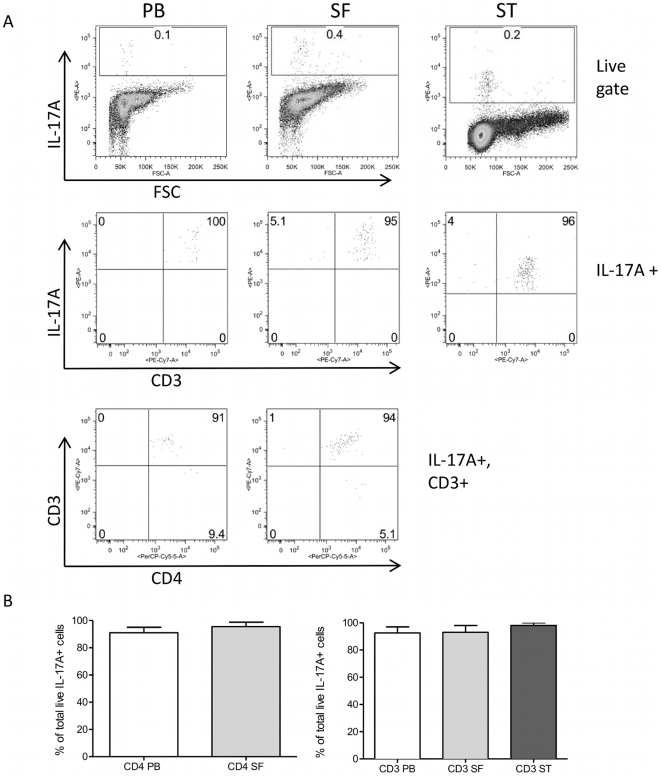
IL-17+ cells from RA PB, SF and ST are predominantly CD3+ T cells.A) PB (n = 18), SF (n = 10) and ST (n = 6)-derived cells were prepared as described in the Methods, and live cells were gated using forward and side scatter profiles. IL-17+ cells were identified based on isotype control staining, and the percentage of either CD3+ or CD3+CD4+ T cells within the IL-17+ gate determined for each sample. B) Bar graphs showing mean and SD of the percentage CD4+ T cells within the IL-17+ population for PB and SF, and of the percentage CD3+ T cells within the IL-17+ population for PB, SF and ST.